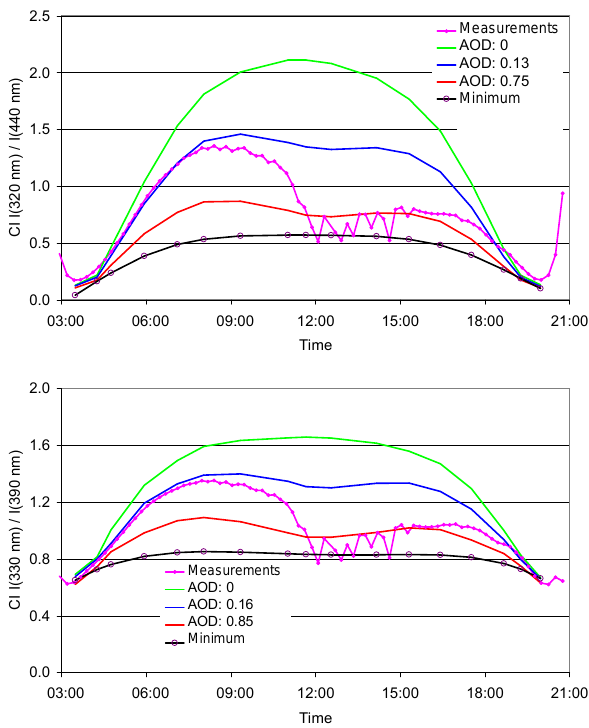
Figure 10. Comparison of measured normalised CI for 24 June 2009 with simulated CI for different scenarios. Top: original CI for 320 and 440nm; Bottom: new CI for 330nm/390nm. The AOD val- ues in the legends correspond to the wavelengths 440 and 390nm respectively. The blue curves represent CI for the AOD measured by the AERONET instrument on the morning of 24 June 2009. The red curves represent CI for the threshold values used in the new classi- fication scheme. The minimum values represent cloudy conditions (see Fig. 1). The simulations are made for a day (26 June 2009) in the middle of the campaign.